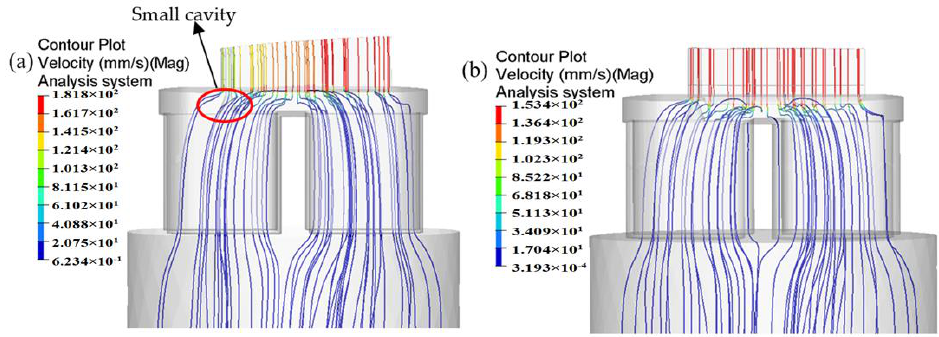
Figure 16. Comparison of metal flow patterns in porthole die: ( a ) the initial die and ( b ) the optimal die.